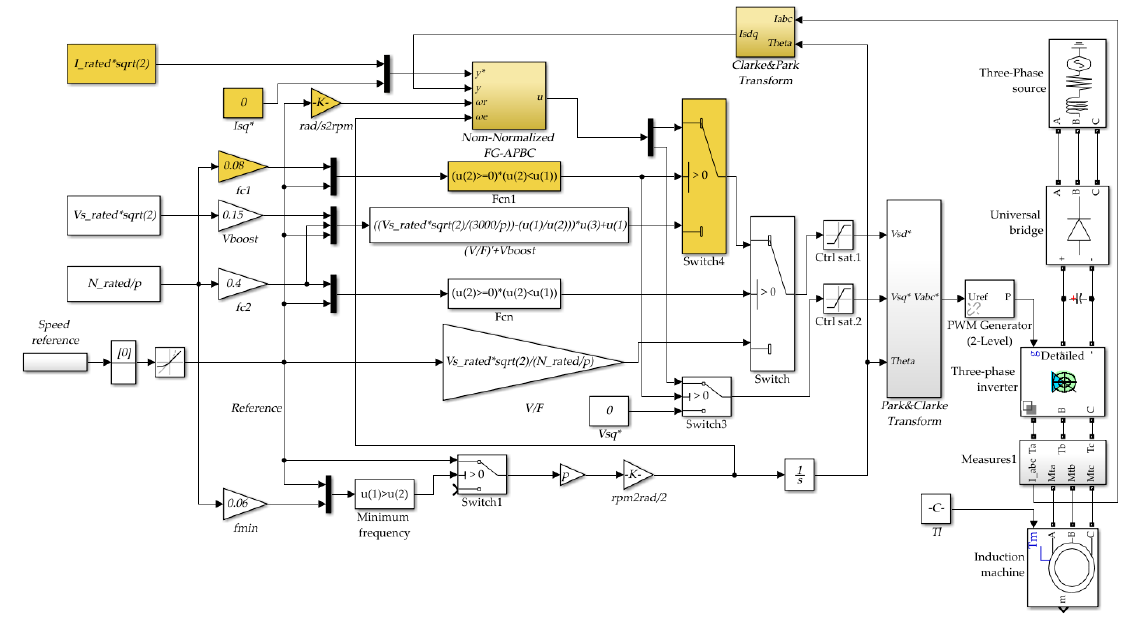
Figure 2. Simulink block diagram of the proposed HST-SCS for the IM.